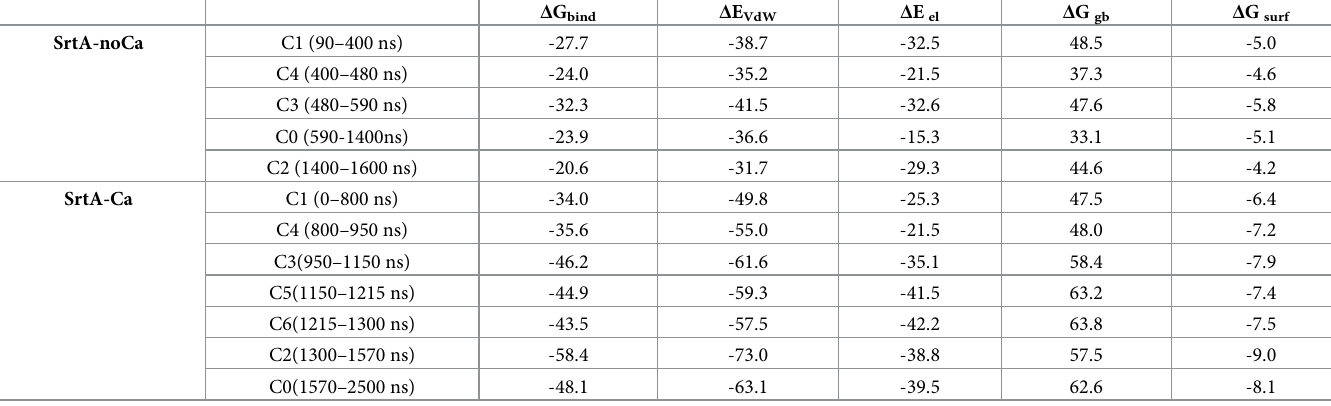
Table 1. MMGBSA-based binding affinities ( Δ G bind ) and their components ( Δ E VdW , Δ E el , Δ G gb , Δ G surf ) [kcal/mol] of the sorting signal peptide to the cluster repre- sentative conformations of SrtA as extracted from the simulations. Δ G bind